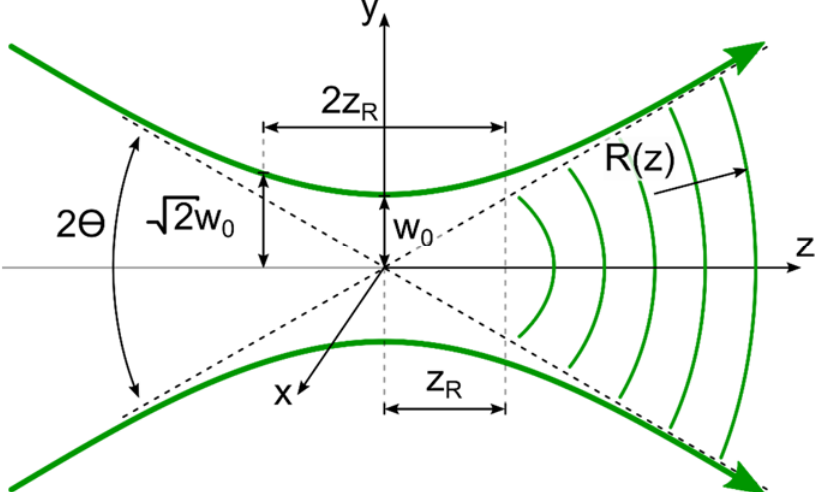
Figure 1. Spatial structure of the laser beam.